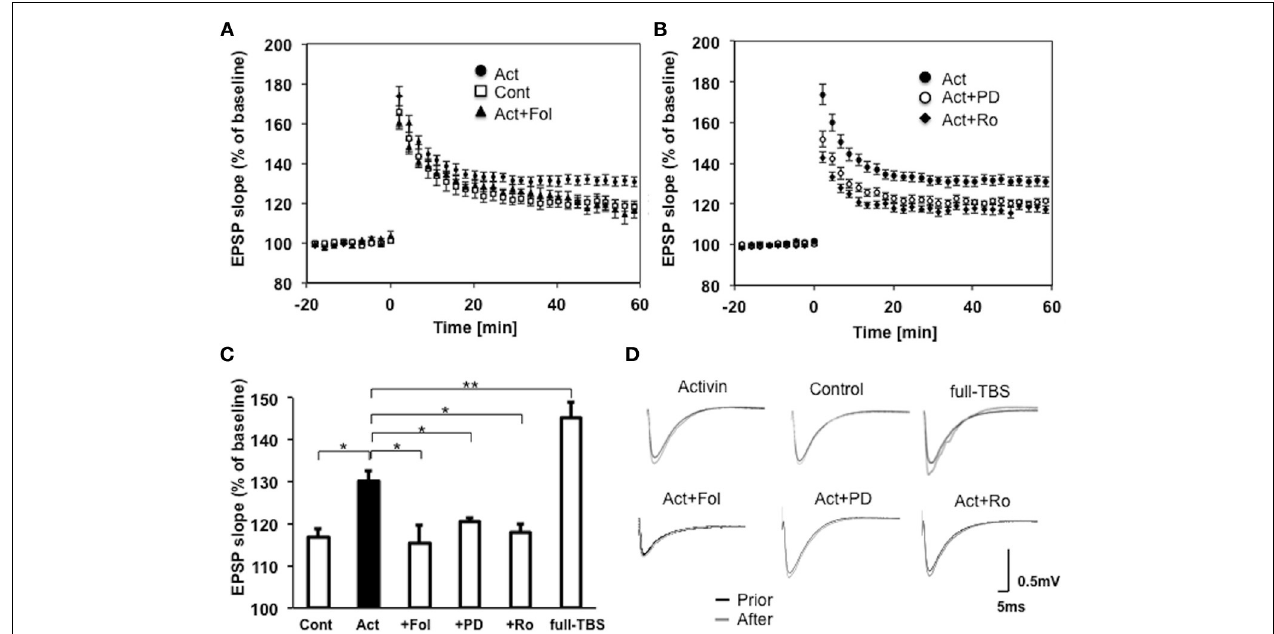
FIGURE 6 | (A) Induction of moderate LTP by weak-TBS stimulation after short incubation ( ∼ 2h) with activin in the CA1 of hippocampal slices. Slices with 0ng/ml activin (control, open square, n = 10 slices, 10 rats), with 10ng/ml activin (closed circle, n = 10 slices, 10 rats), with 10ng/ml activin plus 100ng/ml follistatin (closed triangle, n = 7 slices, 7 rats), with respectively. The number of independent experiments is indicated as n . Vertical axis indicates EPSP slope. Here, 100% refers to the EPSP slope value of the average of t = − 10 to − 1min prior to weak-TBS stimulation. LTP was induced at time t = 0. Illustrated data points and error bars represent the mean ± s.e.m. from n of independent slices. (B) Co-incubation of activin with MAPK inhibitor PD98059 (20 μ M) prevented the induction of LTP (open circle, n = 7 slices, 7 rats). Co-incubation of